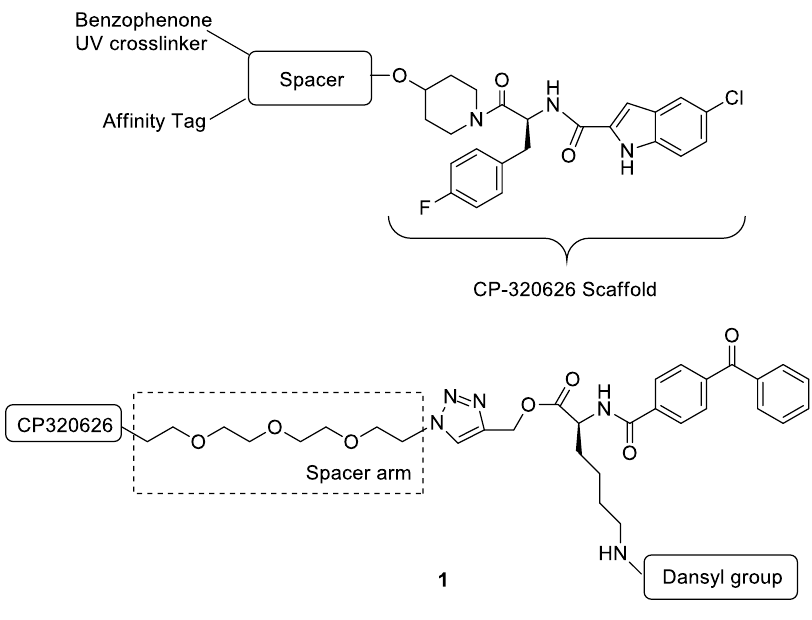
Figure 2. Chemical structures of probes 1 – 3 .